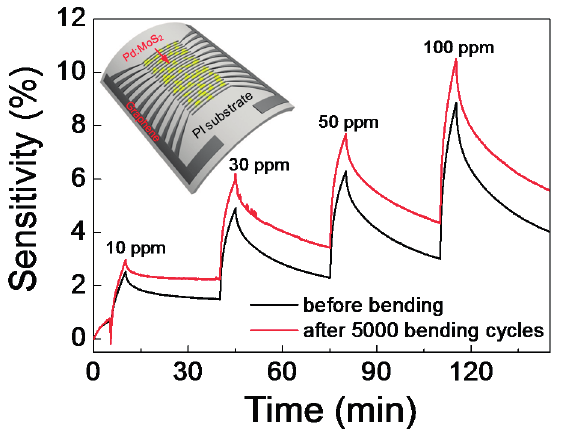
Figure 4. NH 3 gas response characteristics of flexible Pd:MoS 2 gas-sensing device before/after the bending cycle test. The inset shows a 3D schematic image of the bent